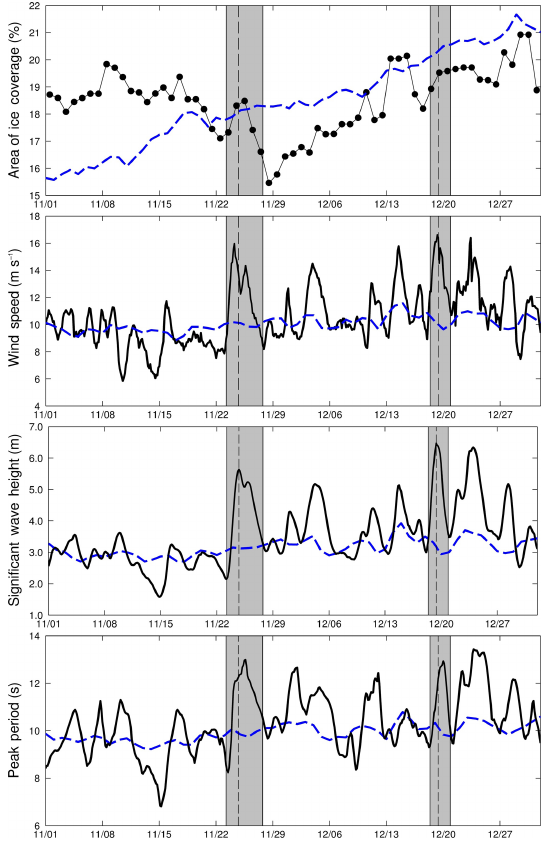
Figure 10. Area-averaged ice coverage, wind speed, significant wave height, and peak period in the Greenland Sea for November– December 1992 (solid line). The dashed line is the daily average from 1992 to